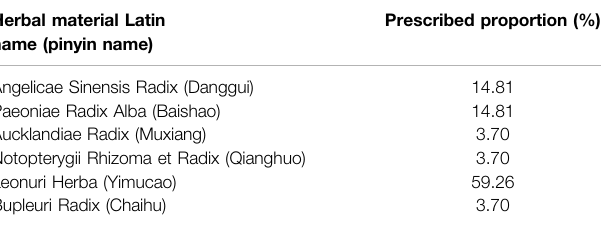
Prescribed proportion